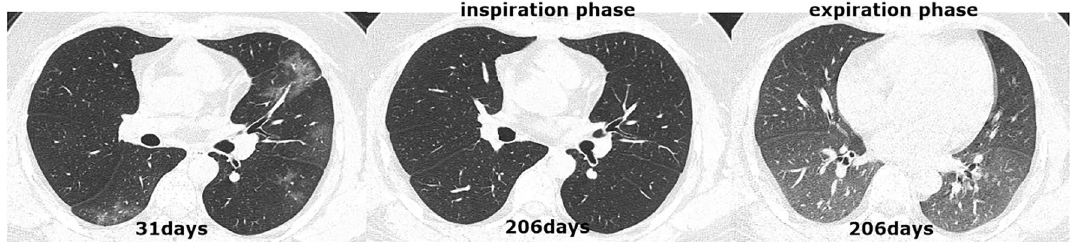
Figure 3. CT scan series in a 65-year-old COVID-19 patient with abnormal DL CO (61.0%) at the six-month follow-up. ( a ) Transverse CT scan obtained 31 days after the onset of symptoms showed multiple consolidations with ground-glass opacities bilaterally. ( b ) Scan obtained during full inspiration on 206 days showed that previous opacifications were markedly dissipated subpleural, irregular linear opacities. ( c ) Scan obtained during expiration at 200 days showed substantial air trapping.